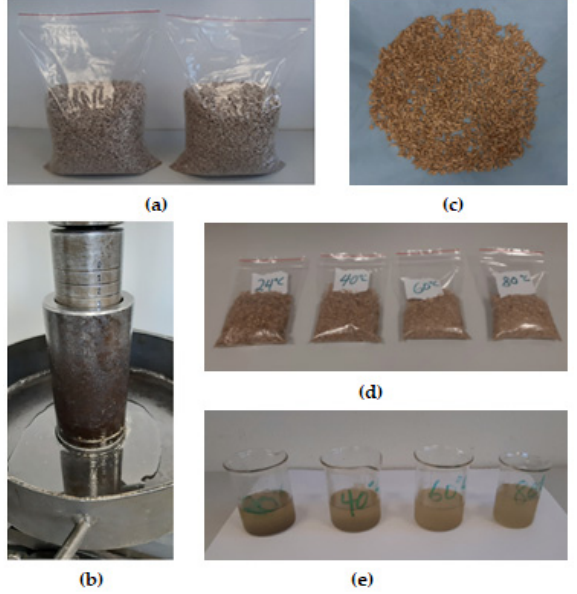
Figure 1. ( a ) Hulled sunflower seeds in sealed transparent plastic bags; ( b ) measured sample load- ed in a pressing vessel with a plunger placed atop showing the extracted oil in a metal pan; ( c ) sample after first pressing spread out on a tissue; ( d ) samples after the fifth repeated pressing